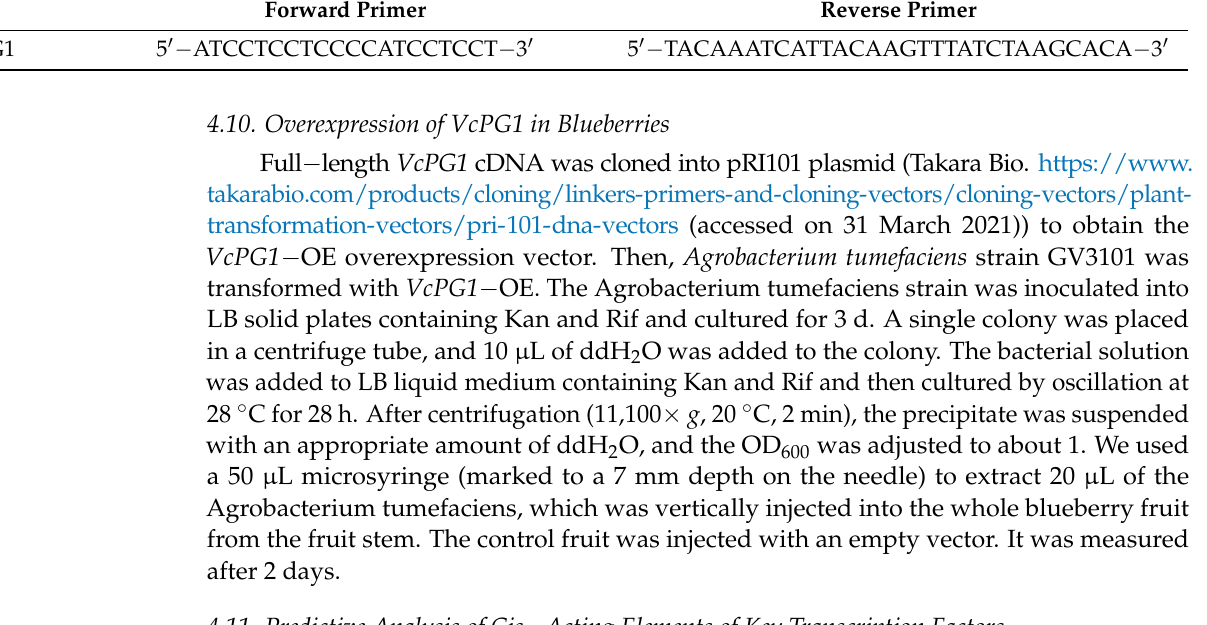
Table 2. The primer sequences for the VcPG1 CDS. Forward